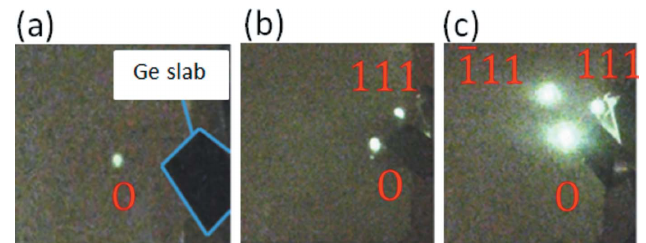
simultaneously 1111 Figure 4 Reflection spots on a fluorescent sheet. ( a ) Directly transmitted X-ray beam denoted as ‘0’, ( b ) direct beam and 111 reflected beam (suggesting the usual Borrmann case) and ( c ) direct beam and 111 and (cid:2) 1111 reflected beams (suggesting the super-Borrmann case).